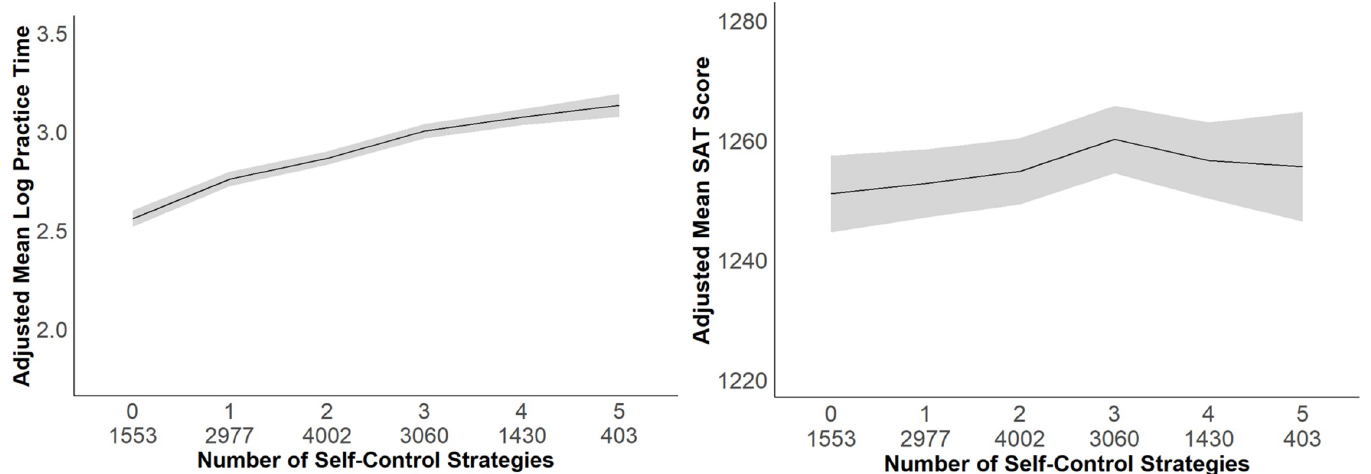
Fig 3. Number of self-control strategies used predicting practice time and SAT scores for Study 2. Study 2 practice time (panel a ) and SAT score (panel b ) as a function of number of self-control strategies used. Means are adjusted for covariates: PSAT scores, gender, ethnicity, and fee waiver status. Shading indicates 95% confidence